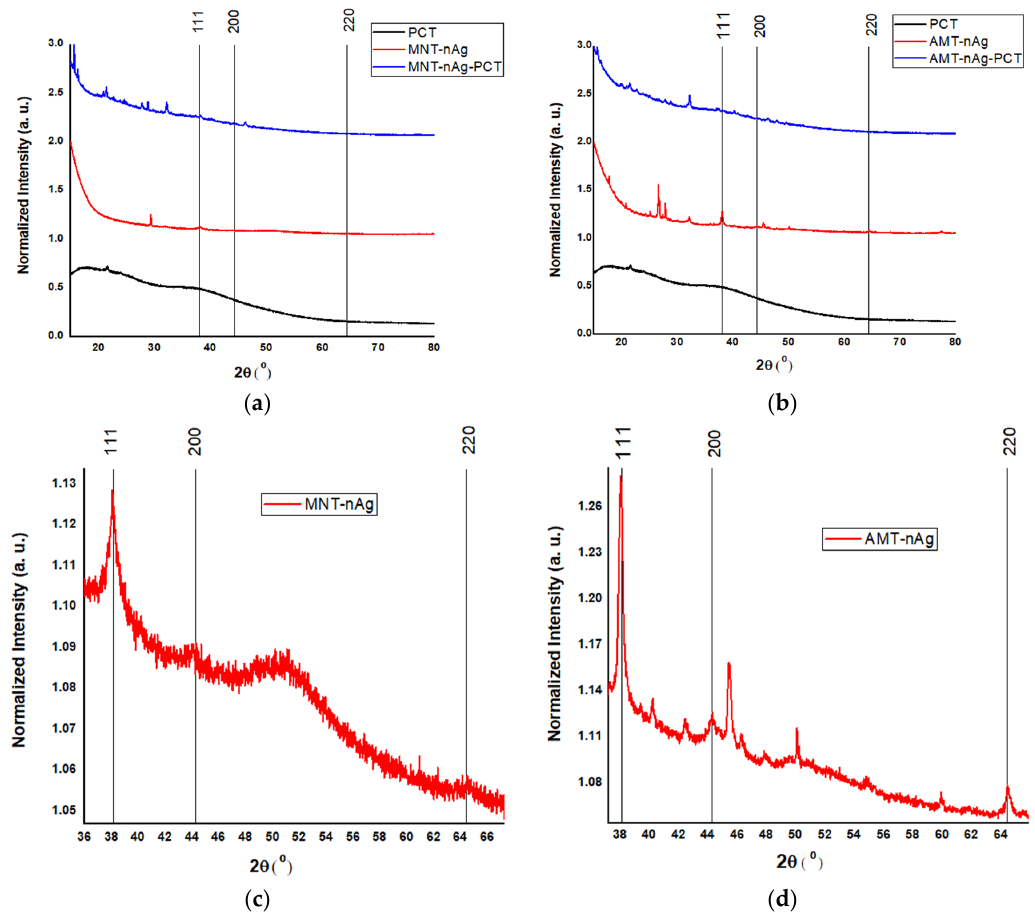
Figure 4. X-ray Diffraction XRD patterns of investigated samples. Comparative representation of diffraction peaks of the samples derived from Mentha piperita ( a ) and Amaranthus retroflexus ( b ). Typical structural signature of silver in cubic phase for silver nanoparticles generated from Mentha piperita ( c ) and Amaranthus retroflexus ( d ).